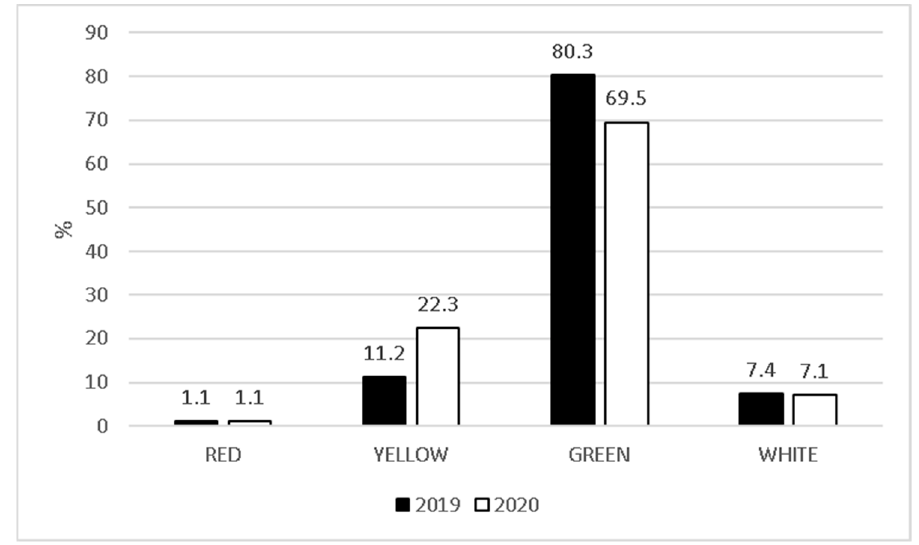
Figure 3. Triage categories from March 9 to May 3, 2019, and the same period in 2020.